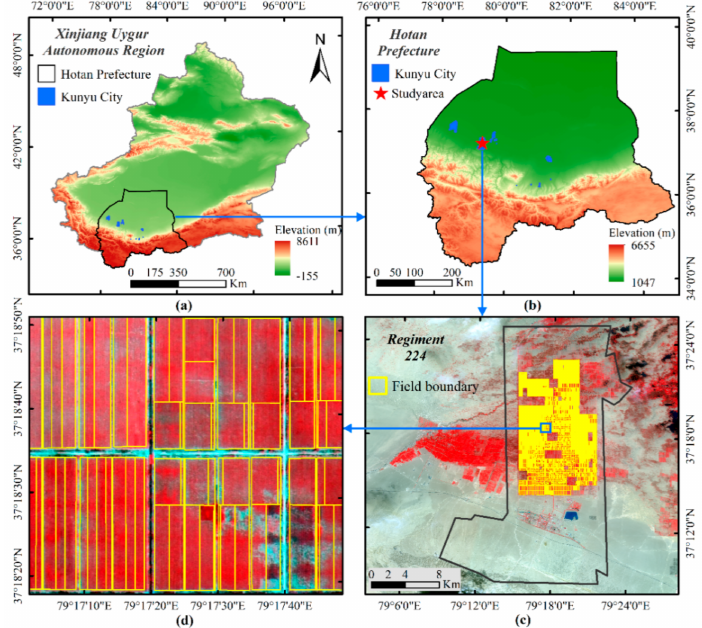
Figure 1. Location of the study area. ( a ) Xinjiang Uygur Autonomous; ( b ) Hotan Prefecture; ( c ) Regi- ment 224 and GF6 color-infrared (CIR) composite image; ( d ) zoomed-in jujube